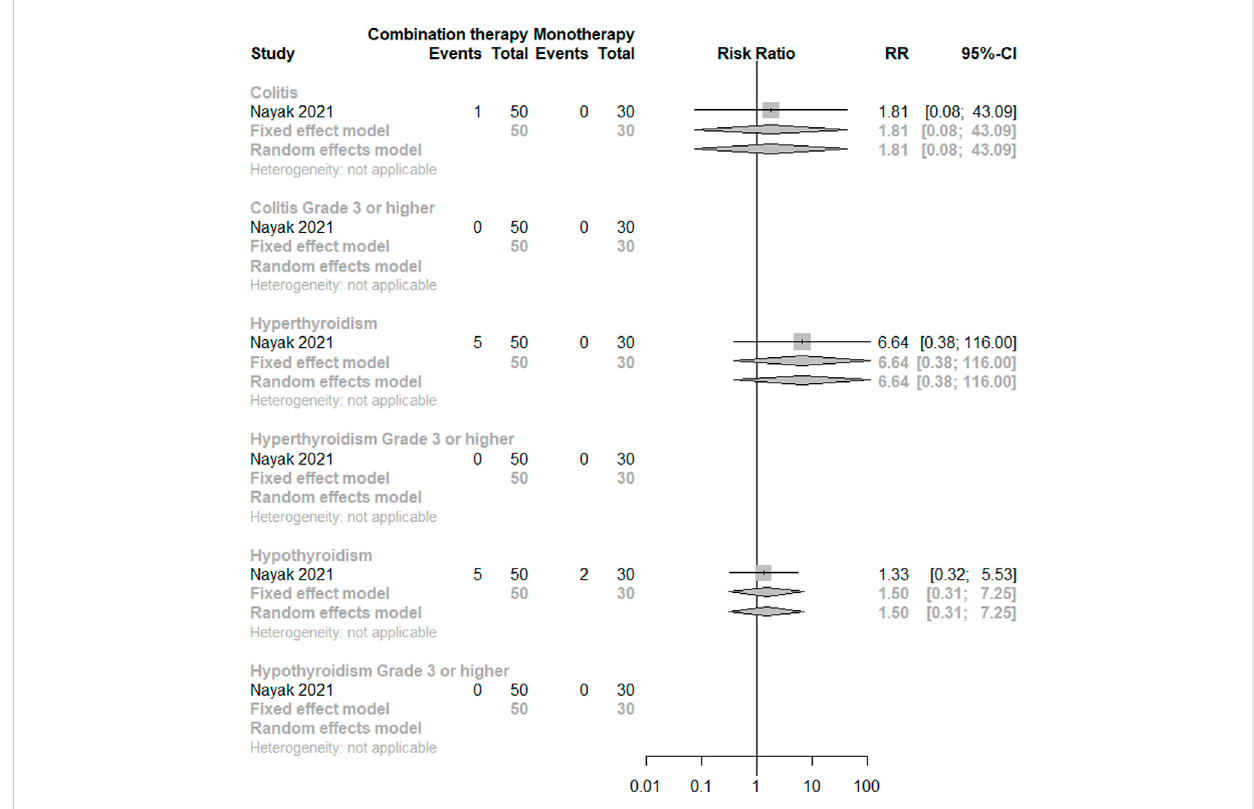
FIGURE 4 Direct comparisons of PD-(L)1 inhibitor monotherapy and in combination with anti-VEGF(R) agents therapy for irAEs.